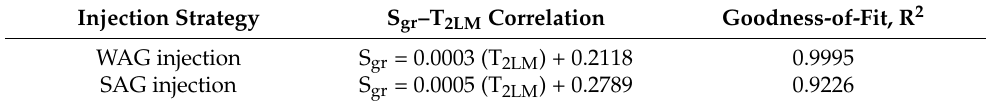
Table 3. Correlations of residual gas saturations versus T 2 log mean